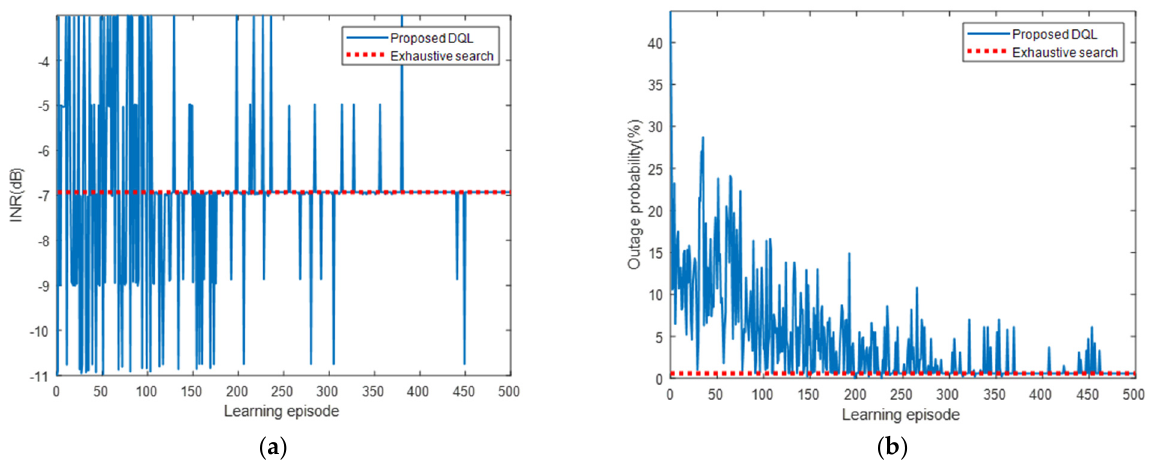
Figure 10. ( a ) 𝐼𝑁𝑅 and ( b ) 𝑝 (cid:3042)(cid:3048)(cid:3047) for each learning episode for interfered receiver ① .